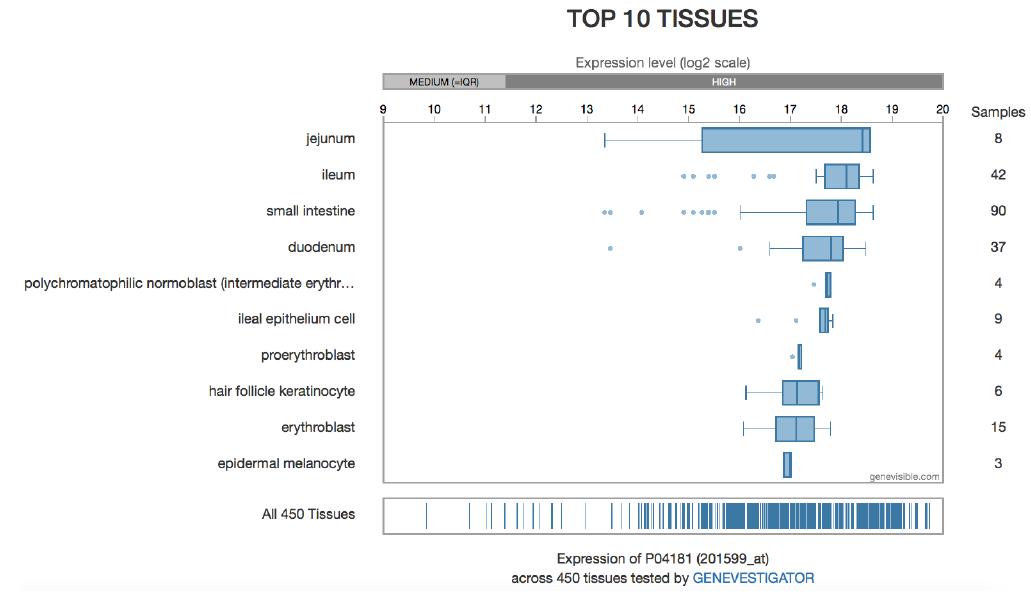
Figure 10. Protein expression levels from microarray data. Table 3. OAT activity measured in various tissues, with no enzyme